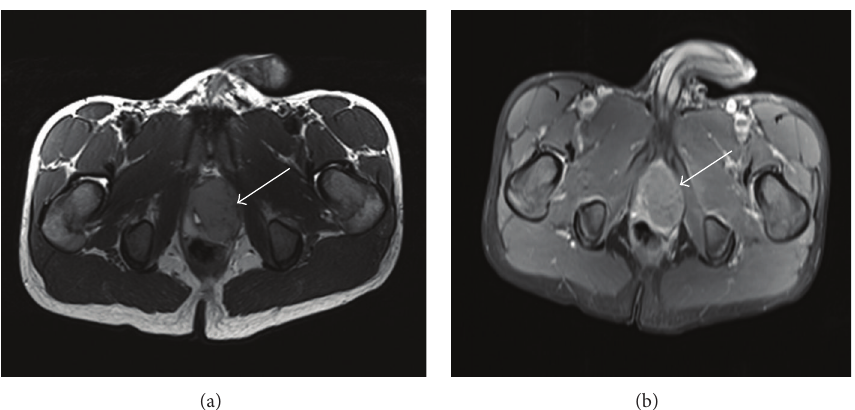
Figure 5: Axial T2 and T1 FS postcontrast images show mildly T2 hyperintense, well- circumscribed, enhancing lesion arising from left lobe of prostate.